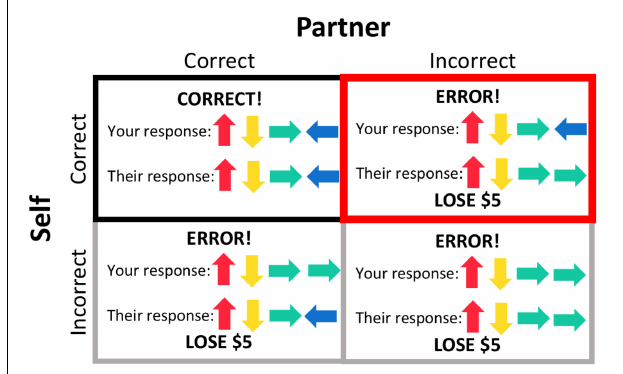
FIGURE 2 | Feedback conditions. The outcome of each trial resulted in one of four feedback conditions, based on the participant’s response and their partner’s response, the latter of which was pre-programmed. Trials during which the participant gave an incorrect response (gray borders) were included as regressors in subject-level processing but not included in group-level analyses. Feedback that both the participant and their partner responded correctly (black border) was used as a baseline for the condition of interest, the “costly error” condition, when the participant responded correctly but their partner did not, resulting in a loss of $5 (red border)